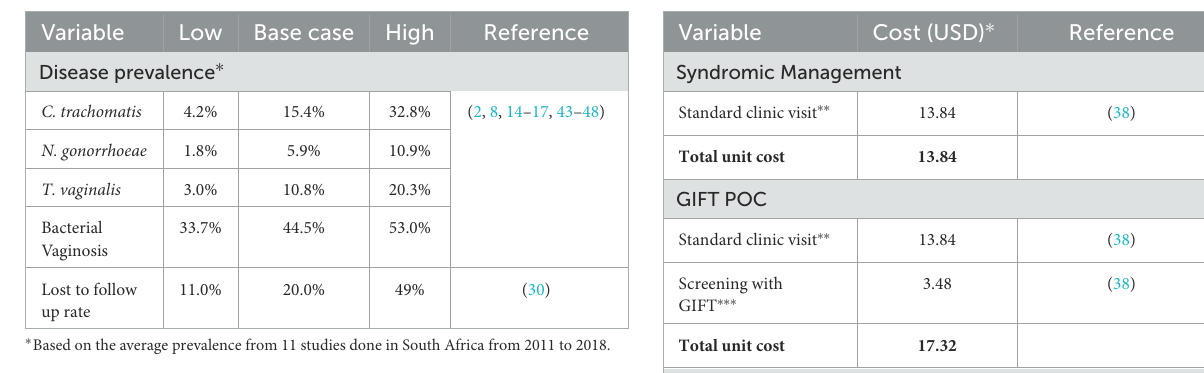
TABLE 2 Base, low and high estimates of the probability of events in the model.